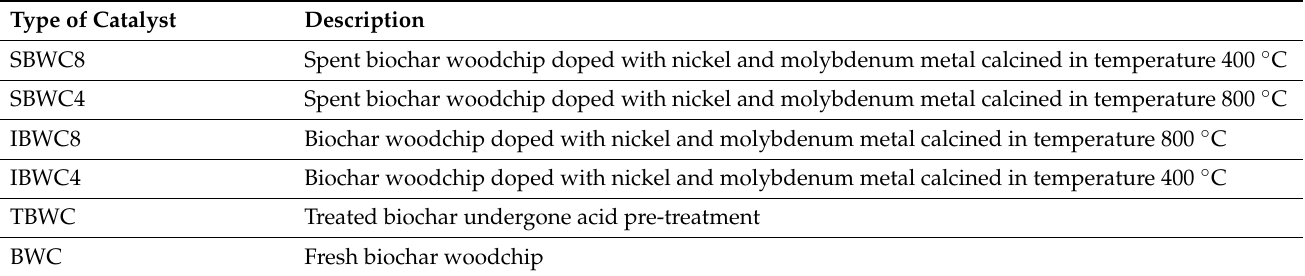
Table 2. Description of the prepared catalyst